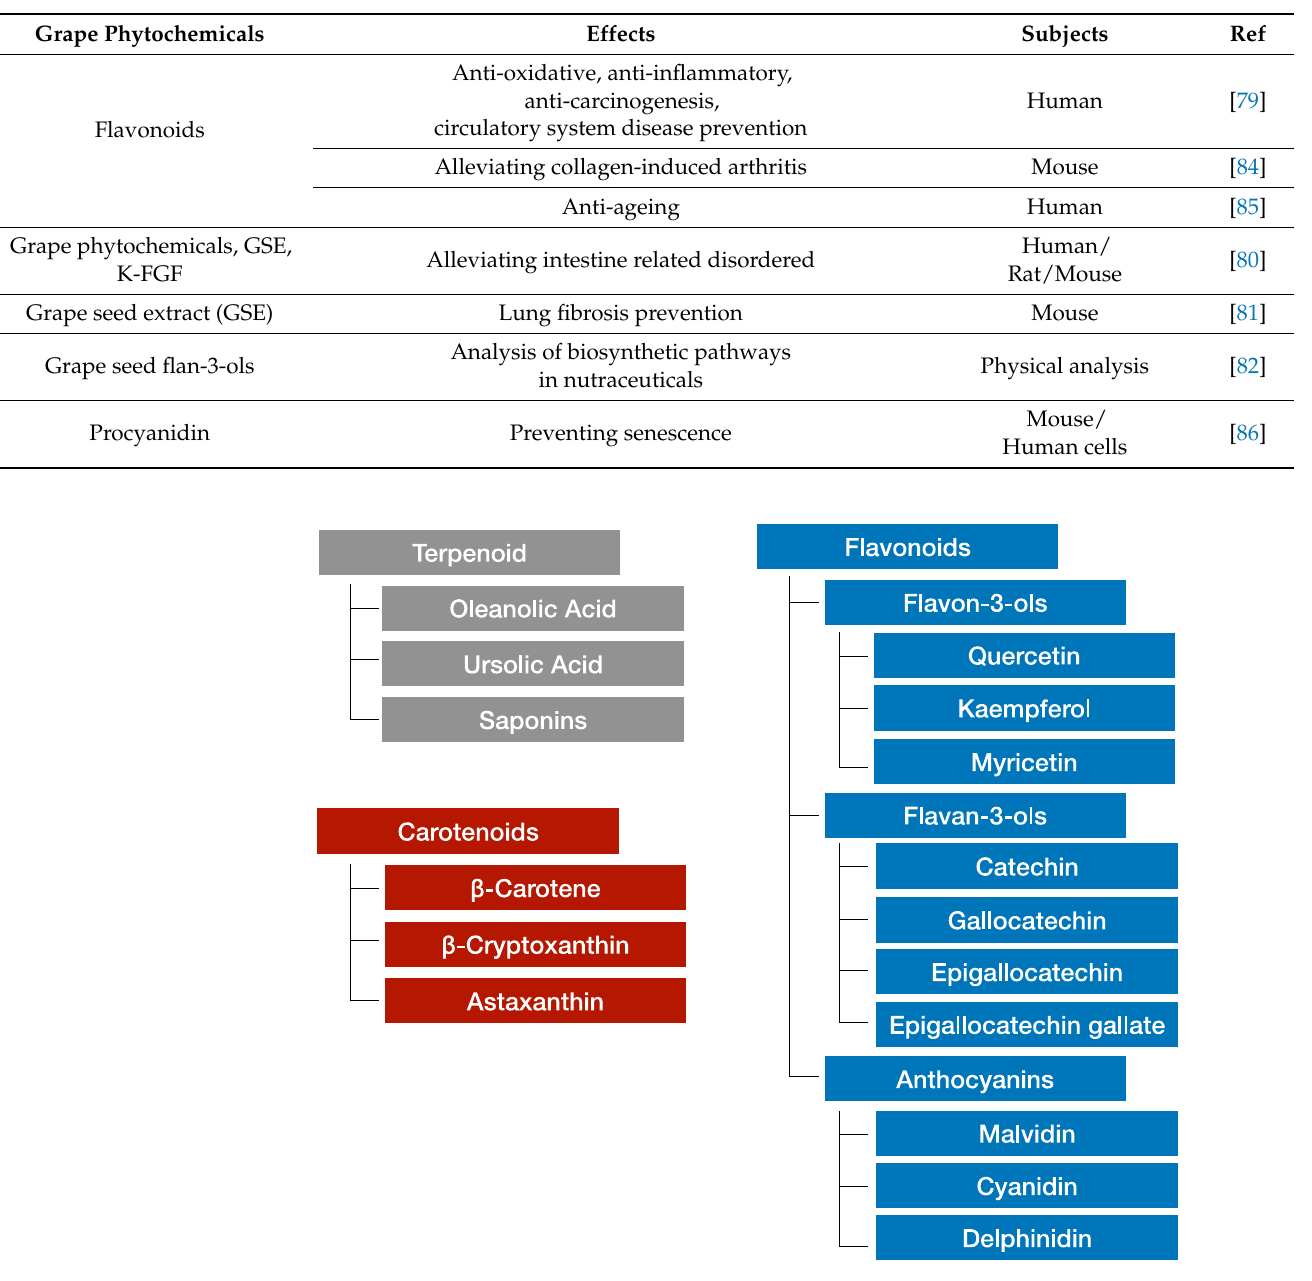
Figure 2. Schematic view of grape phytochemicals in anti-metabolic syndrome and anti-inflammatory effects. This figure shows each grape phytochemical contained in grapes. Grape phytochemicals are classified into terpenoids, carotenoids, and flavonoids. Grape terpenoids are subdivided into oleanolic acid, ursolic acid, and saponins. Grape carotenoids are subdivided into β -carotene, β - cryptoxanthin, and astaxanthin. Grape flavonoids are subdivided into flavon-3-ols, flavan-3-ols, and anthocyanins. Table 2. Anti-metabolic syndrome and anti-in fl ammatory e ff ects of grape phytochemicals.